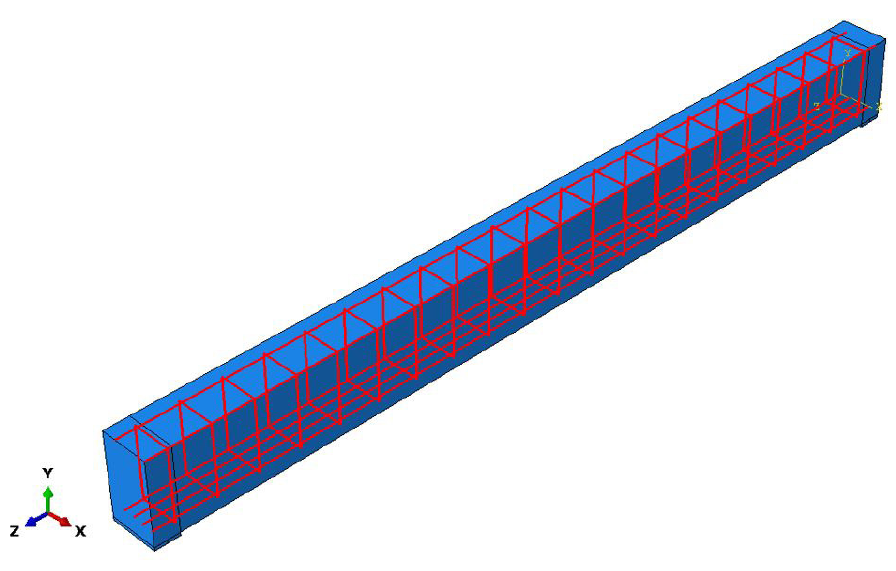
Figure 17: Beam model in ABAQUS.